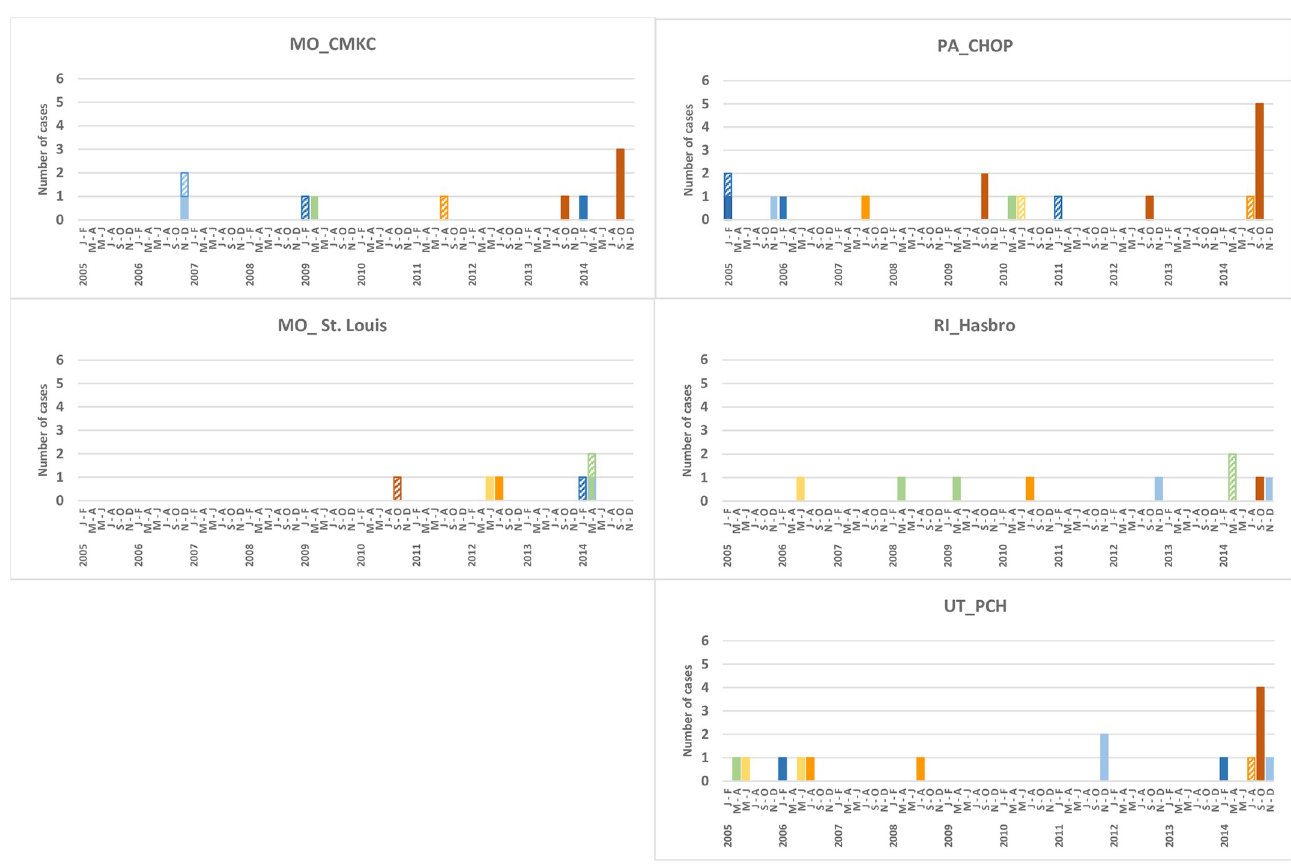
Fig 4. Number of AFM (solid columns) and indeterminate cases (hashed columns) by 2-month periods, by site. Color legend same as in Fig 3.